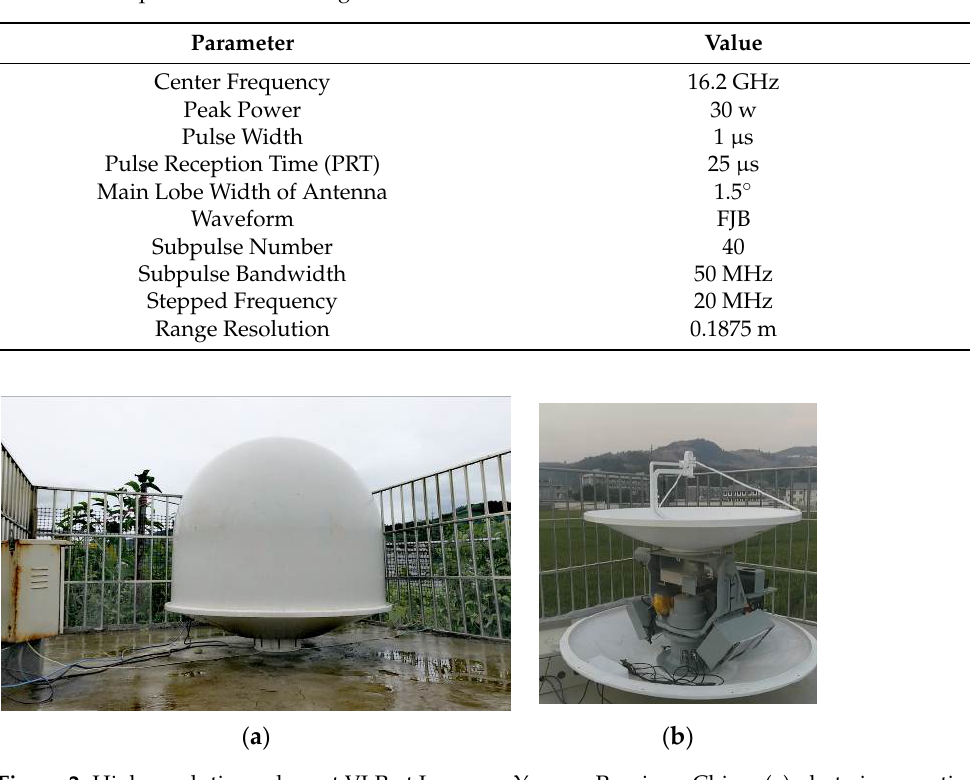
Figure 2. High-resolution coherent VLR at Lancang, Yunnan Province, China: ( a ) photo in operation mode; ( b ) internal structure.